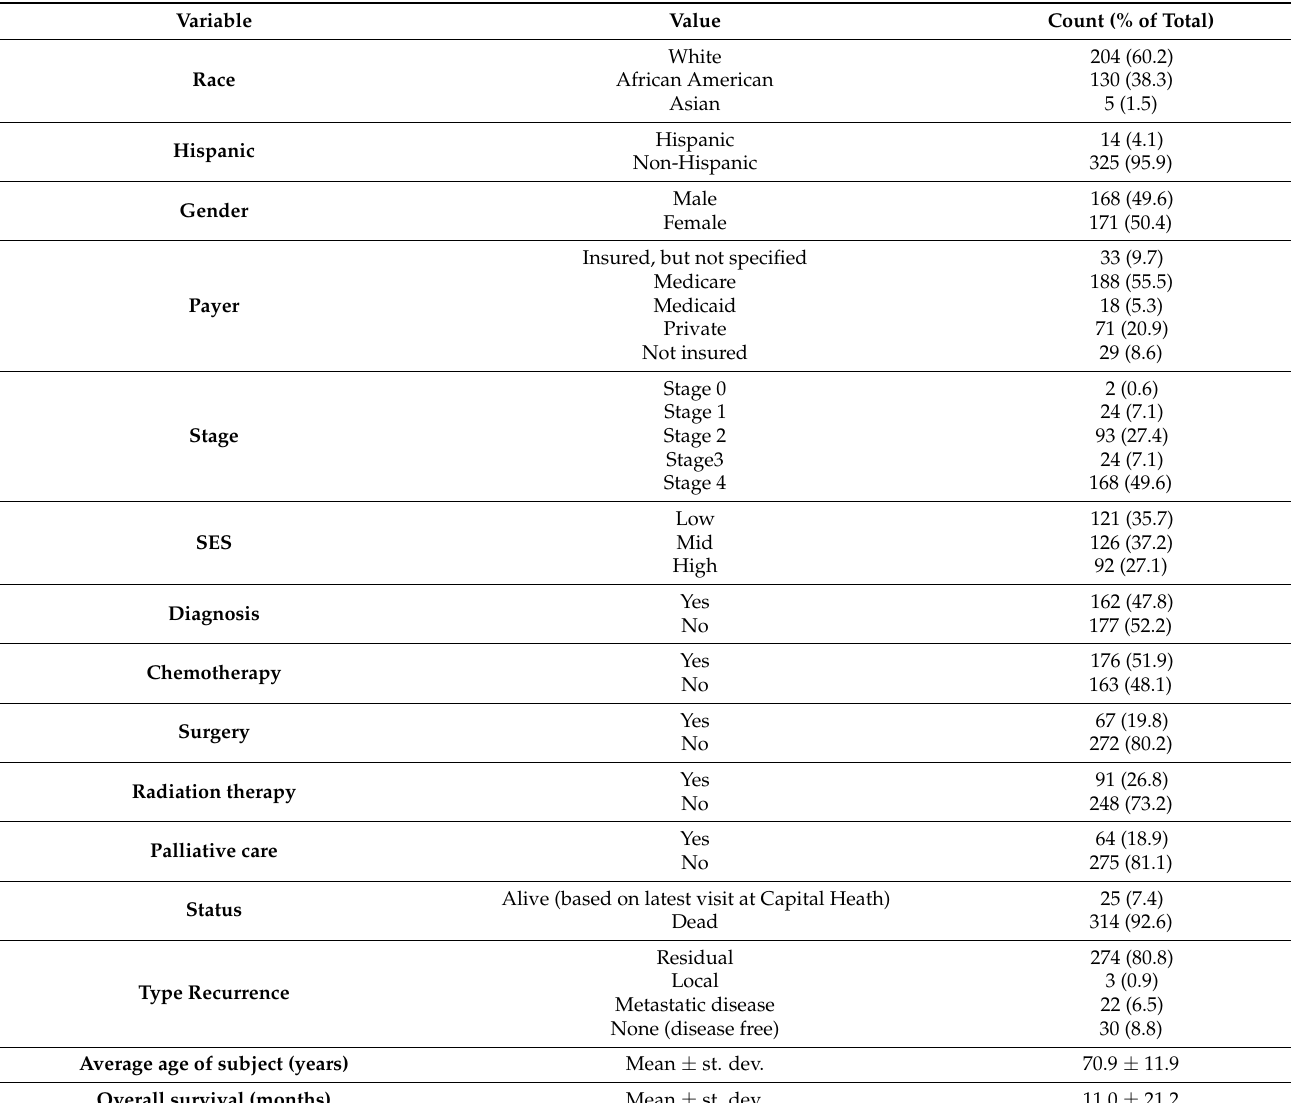
Table 2. Demographics. Description of the total number subjects in the study, organized by: racial or ethnic characteristics, gender, type of insurance (payer), stage at the time of diagnosis, socioeconomic status, type of medical service or surgical service provided either internally or externally of the hospital (diagnosis, chemotherapy, surgery, radiation therapy, palliative care), status based on the most current information (based on the most recent visit), type of recurrence. Age and overall survival (OS) are shown as mean ± standard deviation.